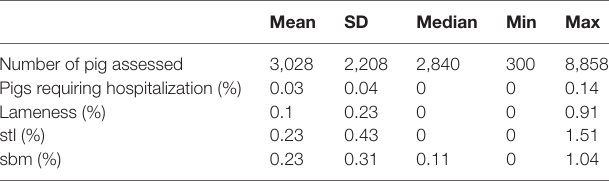
TaBle 7 | Prevalence (%) of the 13 pathologies recorded in British Pig Health Scheme data and mean scores of enzootic pneumonia (ep), pleurisy, and